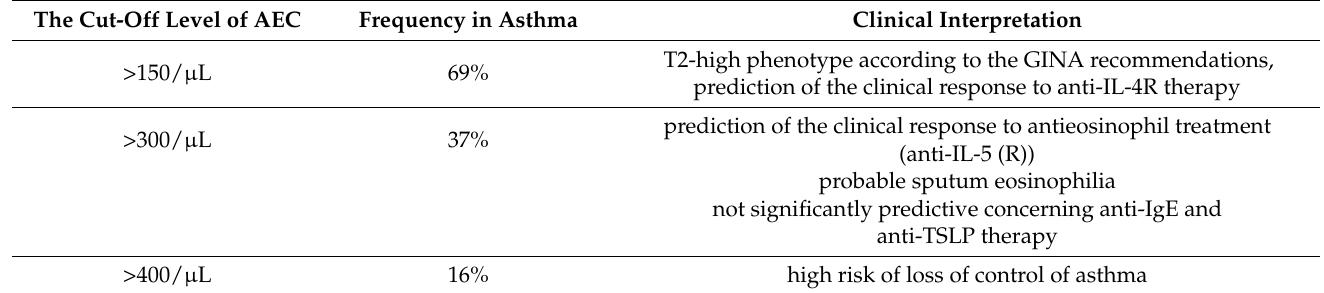
Table 4. Eosinophils in